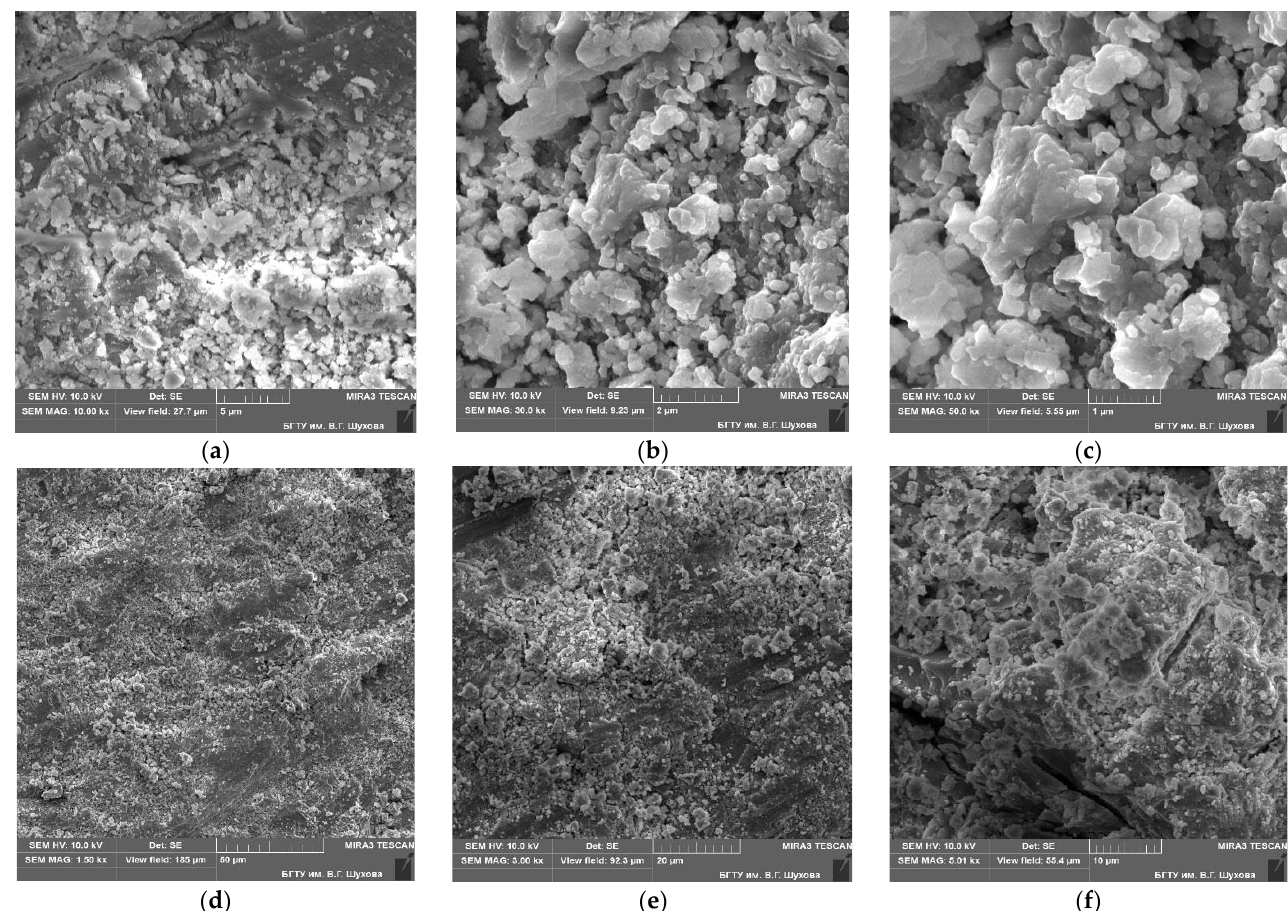
Figure 7. SEM images of the specimen CB-8 at magnifications: ( a ) ×10,000, ( b ) ×30,000, ( c ) ×50,000, ( d ) ×1500, ( e ) ×3000, ( f ) ×5000.